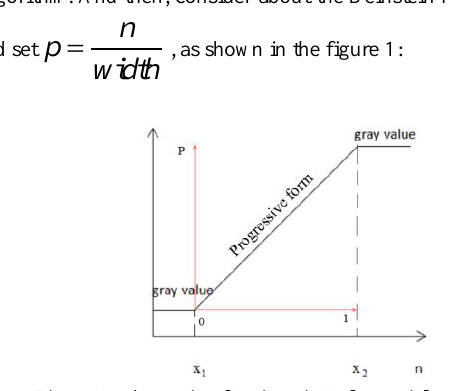
Figure.1 schematic of Beinstein Polynomials graduation algorithm